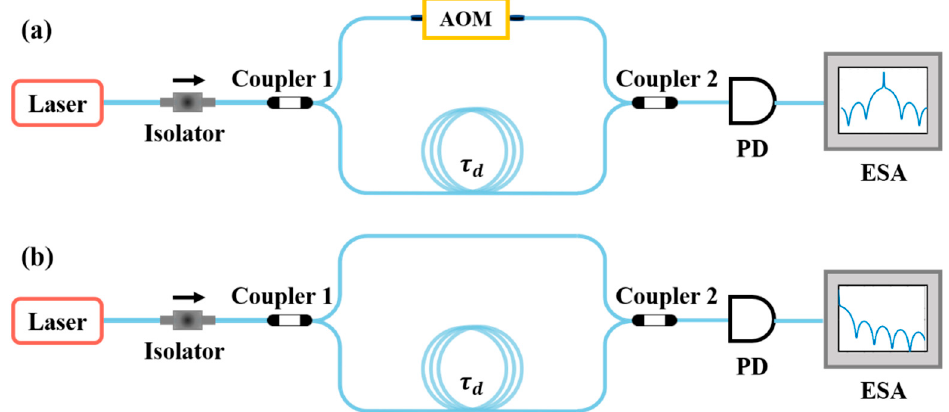
Figure 1. Schematics showing the structures of unbalanced interferometers employed for laser linewidth measurement using a delayed self-heterodyne technique ( a ) and a delayed self-homodyne technique ( b ).